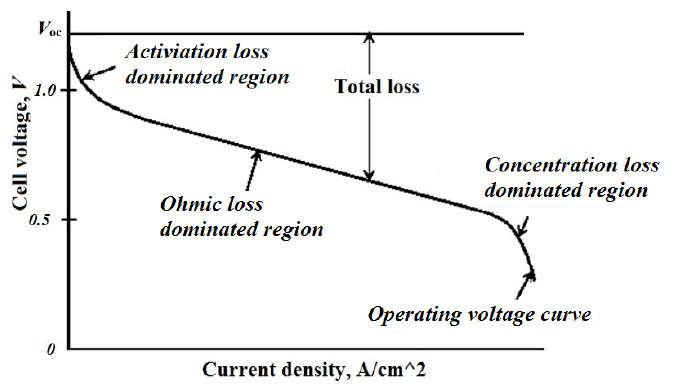
Figure 1. Fuel cell output voltage versus current density.